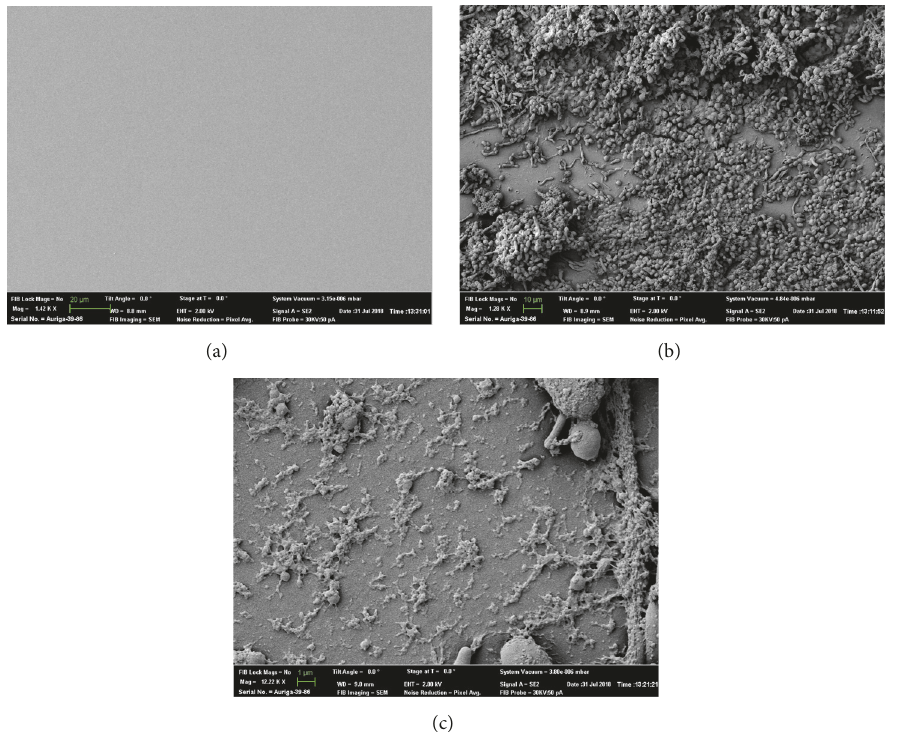
Figure 4: Scanning electron microscopy (SEM) images of polyurethane esophagostomy tubes. (a) The luminal surface of an unused polyurethane tube. The scale bar is equal to 20 𝜇 m and the original magnification is 1.42K. Photo credit: John Dunlap. (b) Thick bacterial and yeast-containing biofilm on the luminal surface of a tube exposed for 204 days in a dog (case 3). The visible tube surface has no evidence of pores or cracks. The scale bar is equal to 10 𝜇 m and the original magnification is 1.28K. Photo credit: John Dunlap. (c) Thin biofilm on the smooth luminal surface of a tube exposed for 204 days in a dog (case 3). The scale bar is equal to 1 𝜇 m and the original magnification is 12.22K. Photo credit: John